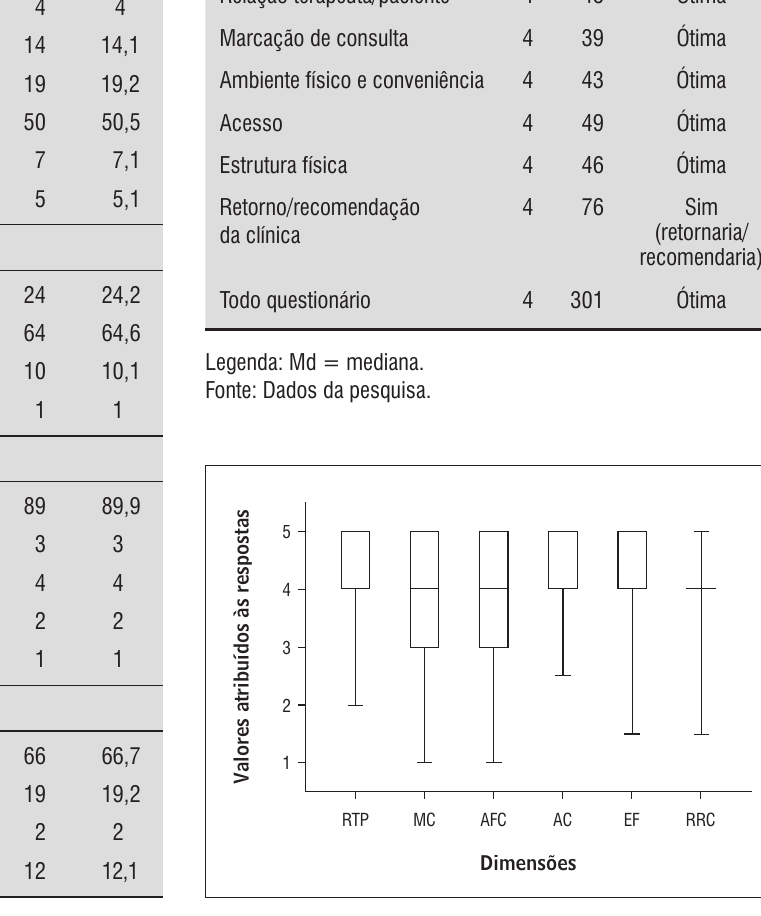
Figura 1 - Distribuição das respostas, valores mínimos, 1º quartil, mediana, 3º quartil e valores máximos Fonte: Dados da